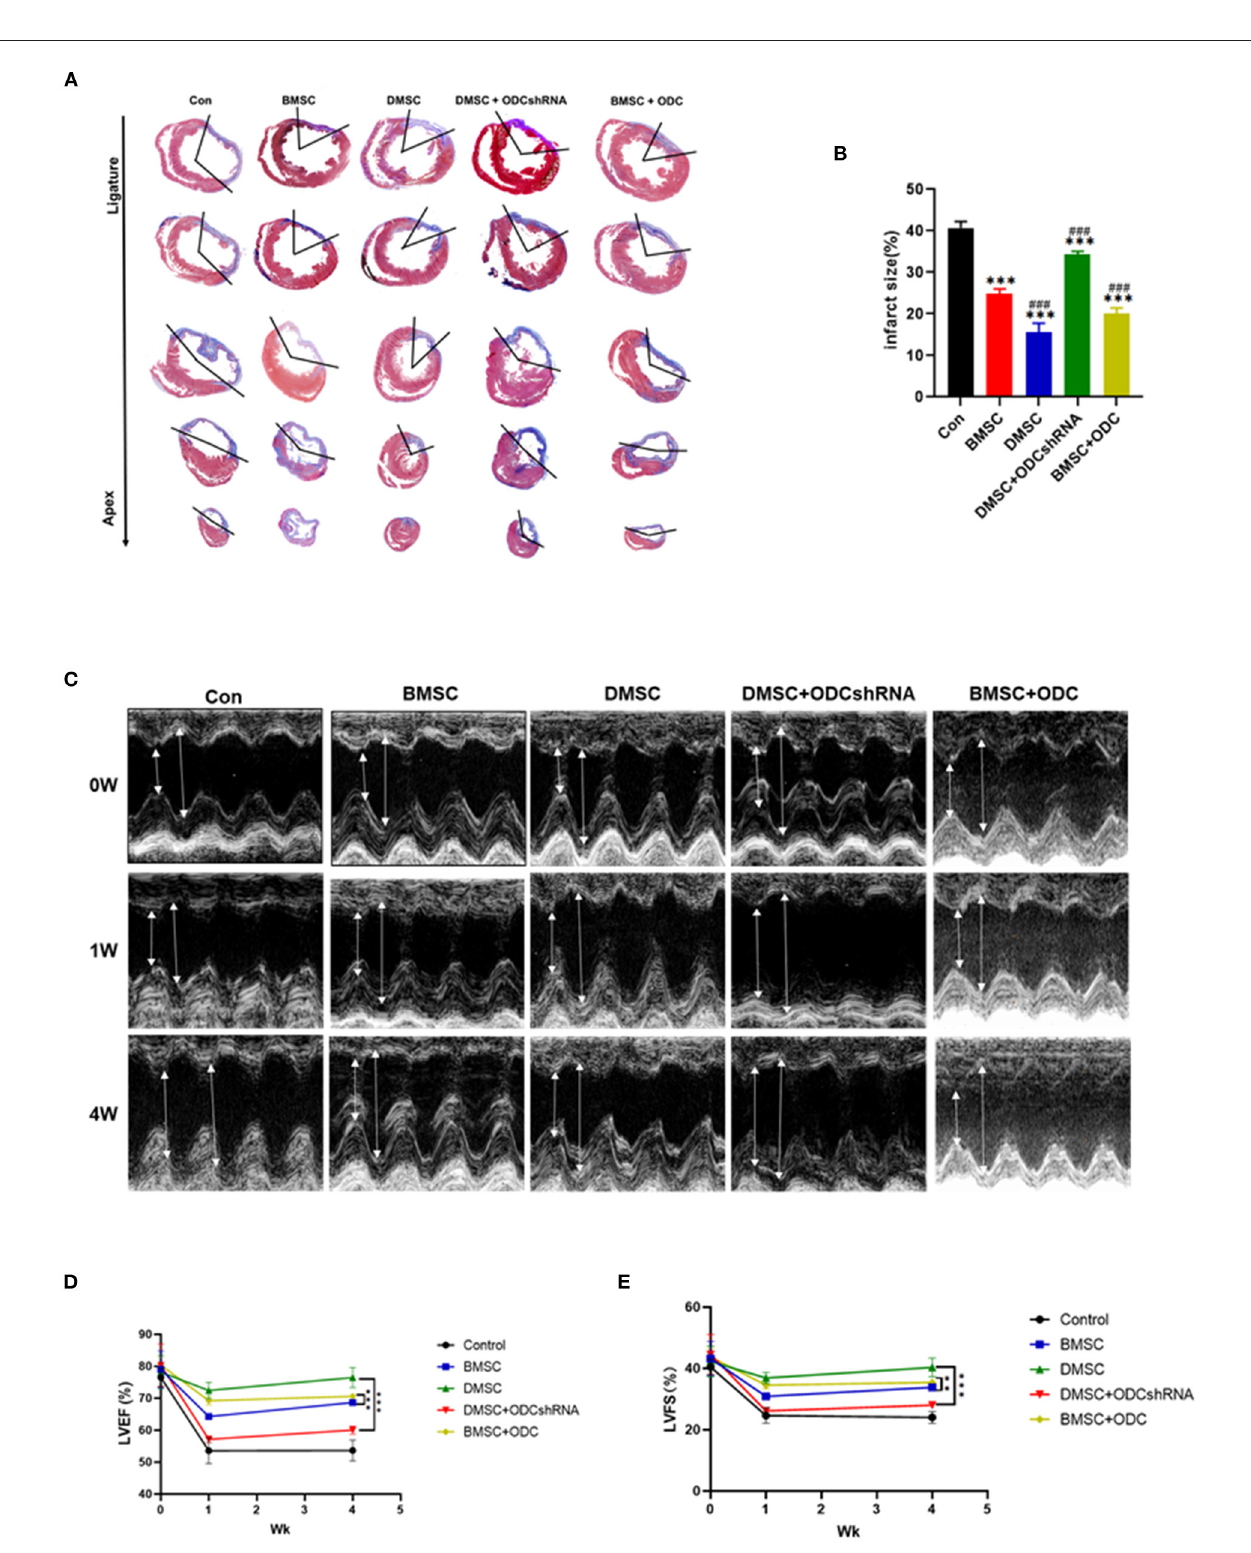
FIGURE 5 | DMSC transplantation improves cardiac remodeling and dysfunction partly via the ornithine decarboxylase-dependent pathway. (A,B) Masson’s trichrome staining to assess the infarct size 4 weeks after cell transplantation (blue = collagen; red = myocardium). Serial sections were cut at 500- µ m intervals from the site of the ligature toward the apex. (C) Representative echocardiography images before and after MI (high lines: LVEDd; low lines: LVESd). (D,E) LVEF and LVFS. (ANOVA; * P < 0.01, ** P < 0.01, *** P < 0.001; n = 5). # P < 0.05, ## P < 0.01, ### P < 0.001.